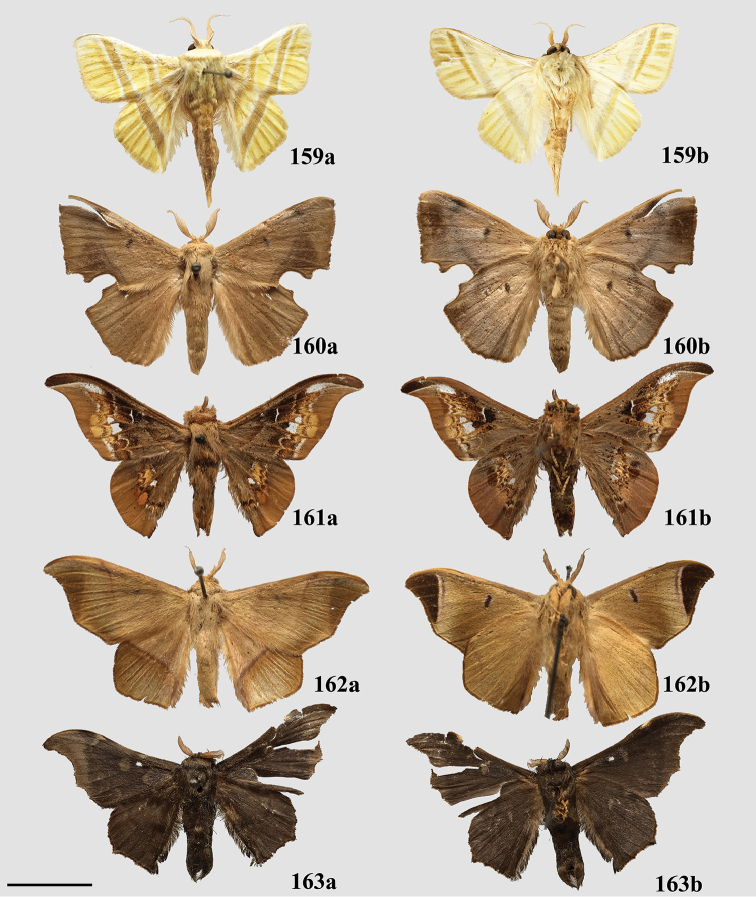
Lectotypes designated in the present work for incertae sedis and Lacosominaea dorsal b ventral. See annotations in Section 4 for complete label data for all lectotypes. All specimens are male 159Hydriasamaryllis Schaus (= Tolypidaamaryllis) 160Trogopteraalthora Schaus 161Adalgisacroesa Schaus 162Perophorapulloides Dognin (= Alheitapulloides) 163Lacosomabriasia Schaus. Scale bar: 1 cm.